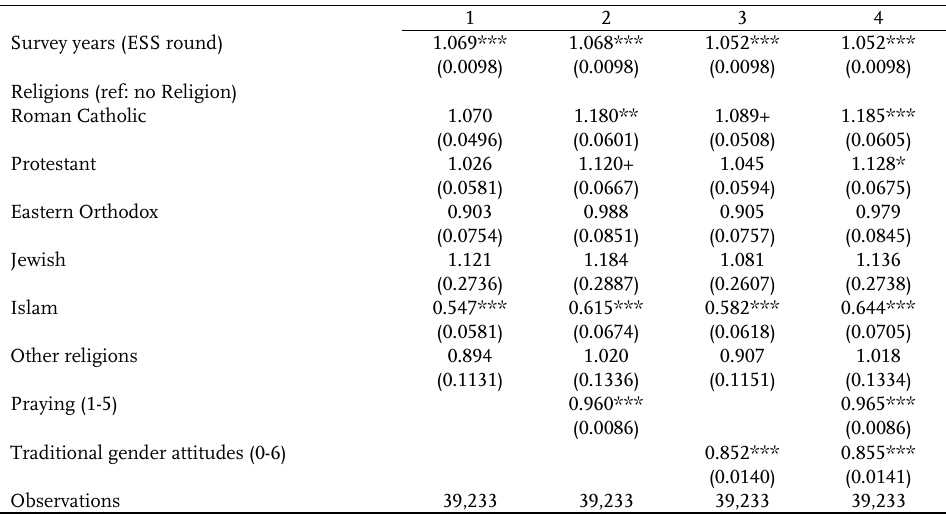
Table A.3 : Odd ratios for role of religiosity and gender role attitudes on employment likelihood of women belonging to different religions (weighted for population size) 1 2 3 4 Survey years (ESS